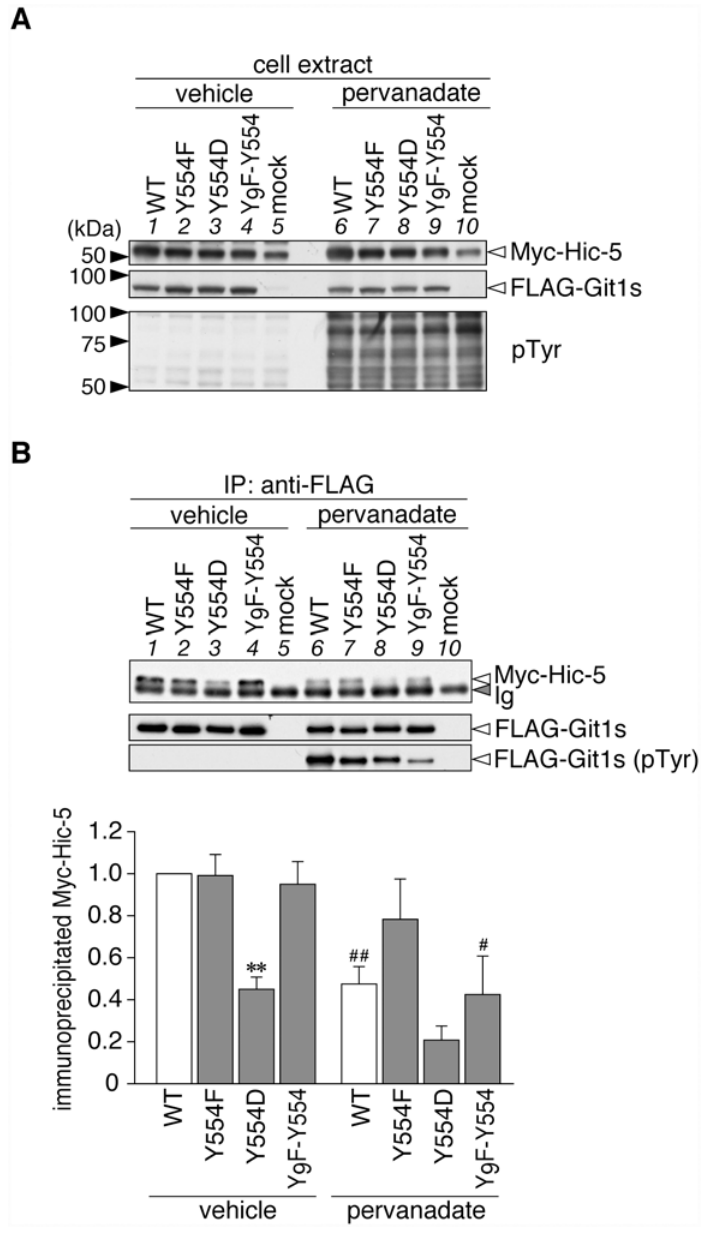
Fig 2. Git1 phosphorylation at Tyr-554 weakened its association with Hic-5. A , Western blotting of protein expression levels, and tyrosine phosphorylation of all proteins in HEK293T cells expressing FLAG- tagged Git1 proteins (Fig. 1A) together with Myc-tagged Hic-5. Cells were treated with 100 μ M pervanadate or vehicle for 15 min, and then analyzed by Western blotting using anti-FLAG M2, anti-Myc 9E10, or anti- phosphotyrosine PY20. B , Co-immunoprecipitaion of Git1 mutants with Hic-5. The immunoprecipitates from cell extracts with anti-FLAG beads were analyzed by Western blotting with an anti-FLAG or anti-Myc antibody. To verify the tyrosine phosphorylation of FLAG-tagged Git1 proteins, the same membrane was reacted with anti-phosphotyrosine PY20. Ig, immunoglobulin. The lower part shows the densitometric analysis of the relative amount of Myc-Hic-5 to FLAG-Git1 in the immunoprecipitates. Data are the mean ± S.E. (error bars; n = 3). ** , P < 0.01 significantly different from the wild-type with the same treatment; # , P < 0.05 or ## , P < 0.01 significant difference between vehicle- and pervanadate-treated groups by ANOVA with Fisher ’ s PLSD post hoc